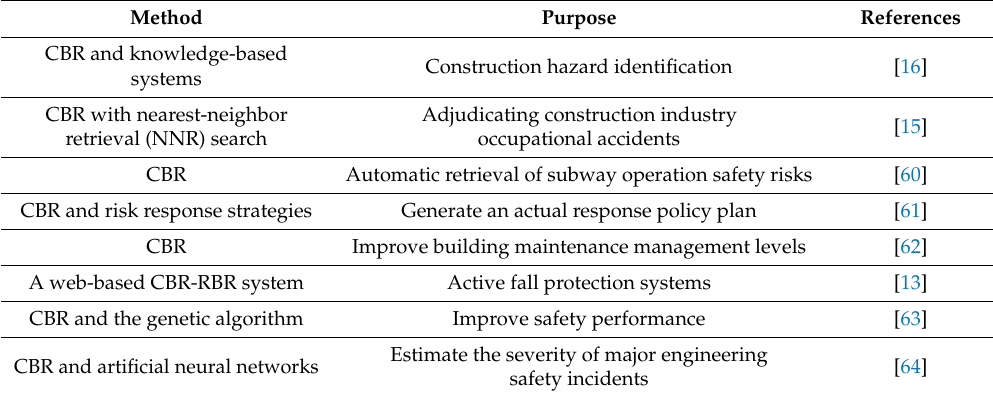
Table 2. Applications of Case-Based Reasoning (CBR) in construction safety